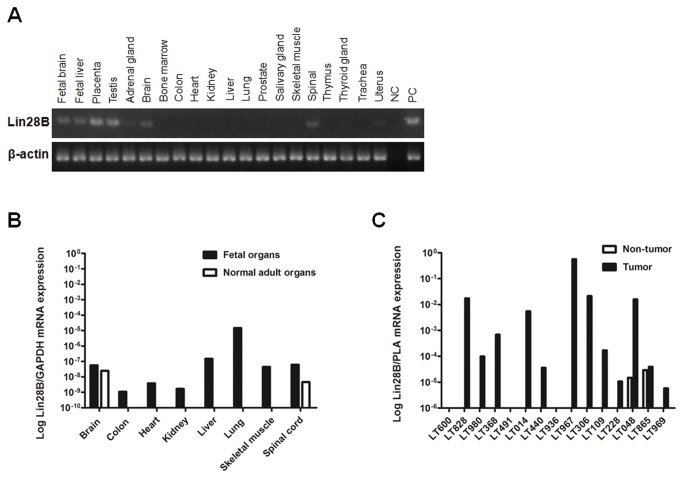
The oncofetal expression profile of Lin28B.
A, RT-PCR showed that Lin28B was expressed in fetal brain and liver and in adult testis, brain, spinal cord and placenta. It was not detected in other adult tissues. B, RT-qPCR showed that Lin28B was markedly downregulated from fetal (closed bar) to adult (open bar) tissues except for the brain. C, RT-qPCR was performed using pairs of HCC (closed bar) and non-tumor (open bar) liver tissues. Overexpression of Lin28B (> 100×) was observed in 8 HCC samples (53.3%). NC, negative control; PC, positive control.